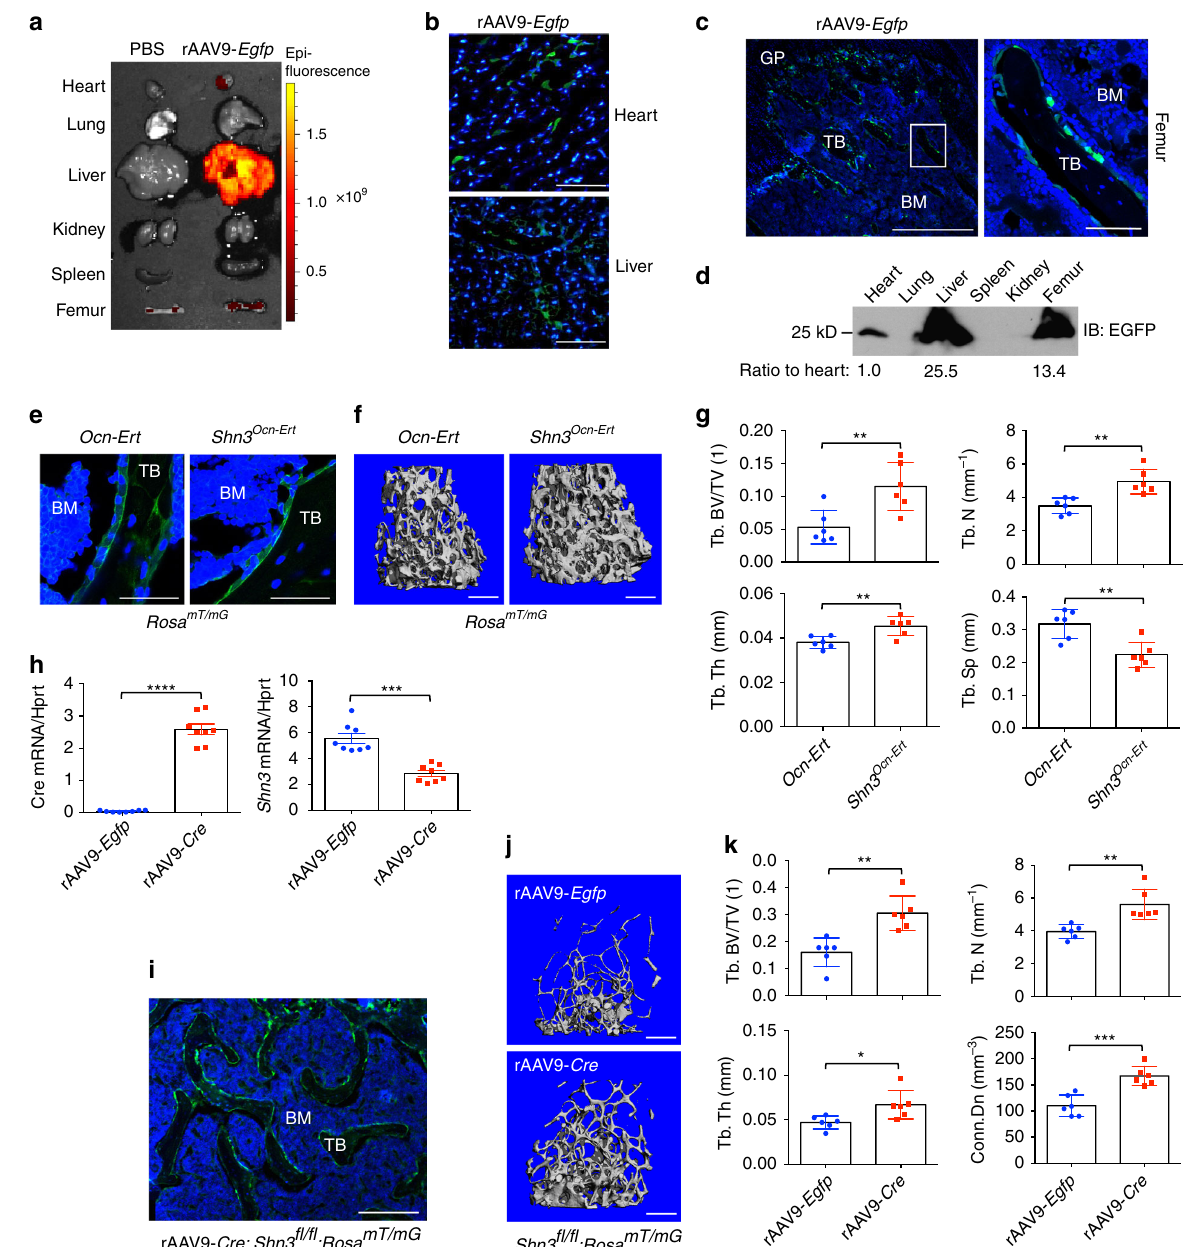
Fig. 2 Inducible deletion of shn3 in osteoblasts increases bone accrual in adult mice. a – d A single dose of 4 × 10 11 genome copies of rAAV9- Egfp was intravenously (i.v.) injected into 2-month-old male mice and EGFP expression in individual tissues was monitored by IVIS-100 optical imaging 2 weeks post injection. y -axis, radiant ef fi ciency (p/s/cm 2 /sr/ μ W/cm 2 ) ( a ). EGFP expression was assessed by fl uorescence microscopy on cryo-sectioned heart,